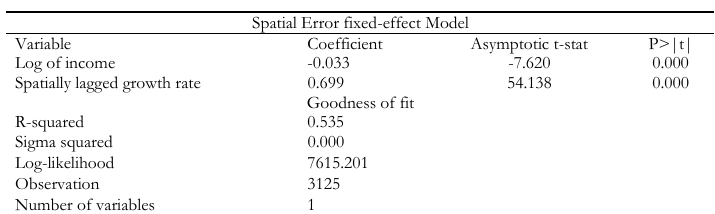
Convergence of per capita income in the 125 European regions (1977-2002) - Estimation of the fixed-effect Spatial Error Model - Equation (4) - (numbers into brackets refer to the